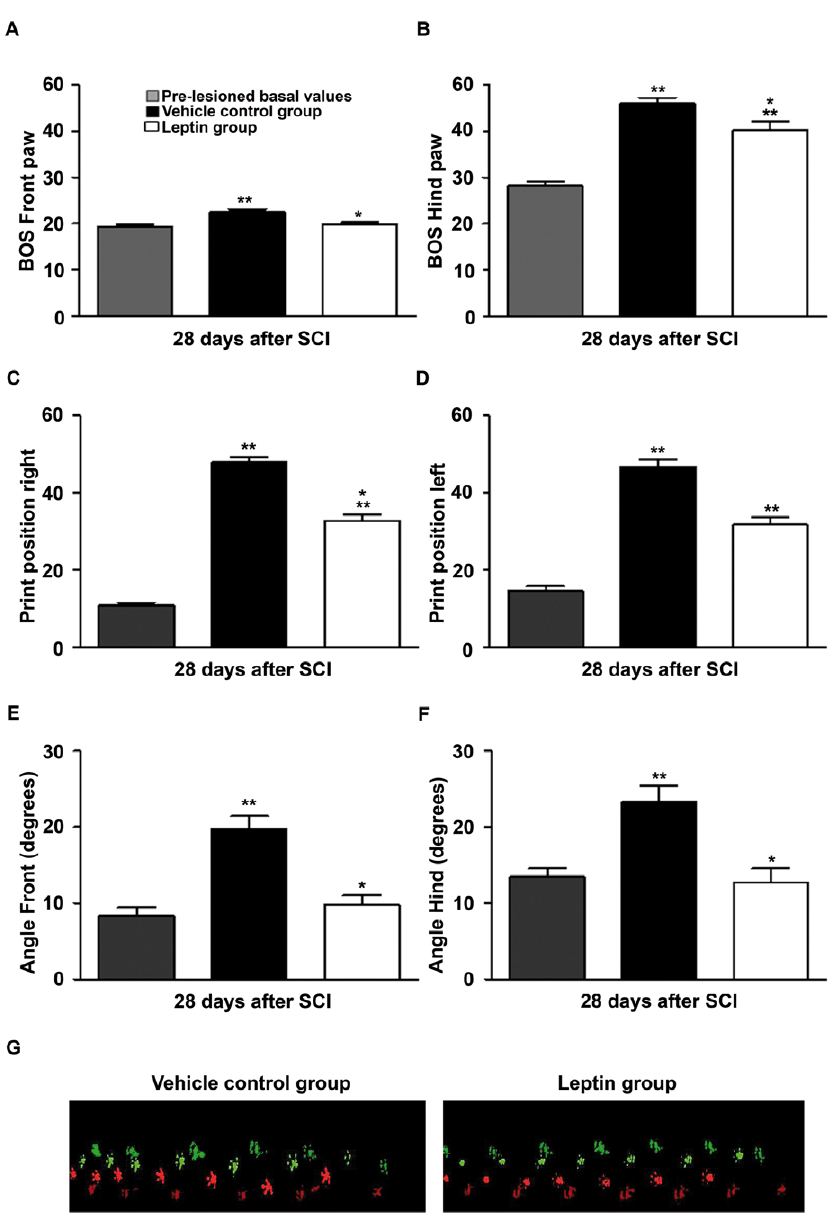
Figure 6. The effect of leptin administration on motor function recovery in the CatWalk system. Gait assessment was performed using the CatWalk H gait analysis system (version 7.1; Noldus) at 28 d post-SCI in 5 uninterrupted and consistent pace trials per animal. Leptin administration decreased the base of support (BOS) of both of the fore (A) and hind (B) paws when compared with vehicle-treated controls. The right/left print position (C and D) and the front/hind paw angle (E and F) in leptin-treated animals were significantly lower than in vehicle-treated controls. (G) Examples of the step sequence pattern analysis in representative vehicle-treated and leptin-treated animals. The values in A–F represent the mean 6 SEM; ** p , 0.0001 versus the basal values in pre-lesioned conditions; * p , 0.001 versus the vehicle control